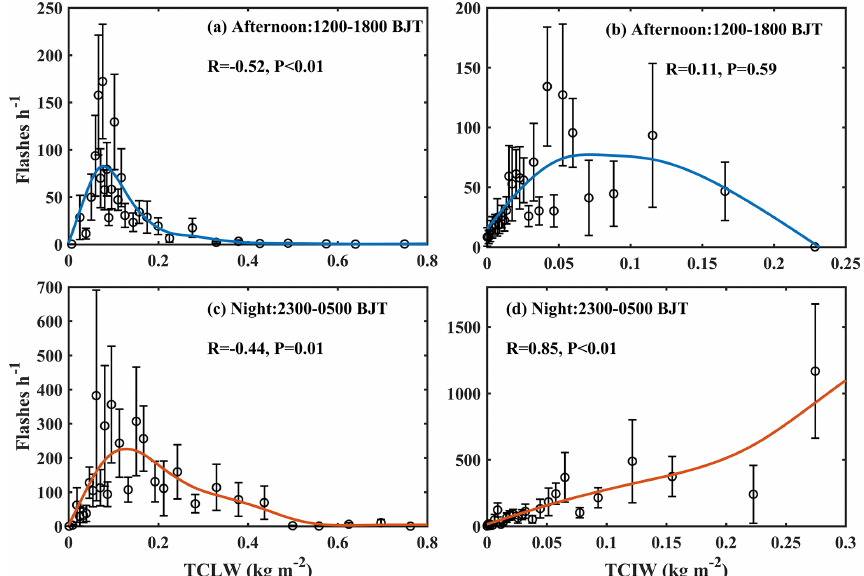
Figure 9. Same as in Fig. 8, but for the (a, c) lightning flashes total column cloud liquid water (TCLW, unit: kgm − 2 ) and (b, d) lightning flashes total column ice water (TCIW, unit: kgm − 2 ). Samples are first sorted by the variable on the x axis and then samples with similar values of the x variable were averaged. The max number of samples in each bin is equal to or less than 20. The difference between the maximum and minimum (a, c) TCLW and (b, d) TCIW values of samples in each bin is equal to or less than 0.05 and 0.01. An estimation of the uncertainty was calculated from the standard deviation of each bin divided by the square root of the number of data points in the bin. Smoothing spline-fit curves, Pearson correlation coefficients ( R ), and significant level ( P ) are also shown in each panel.